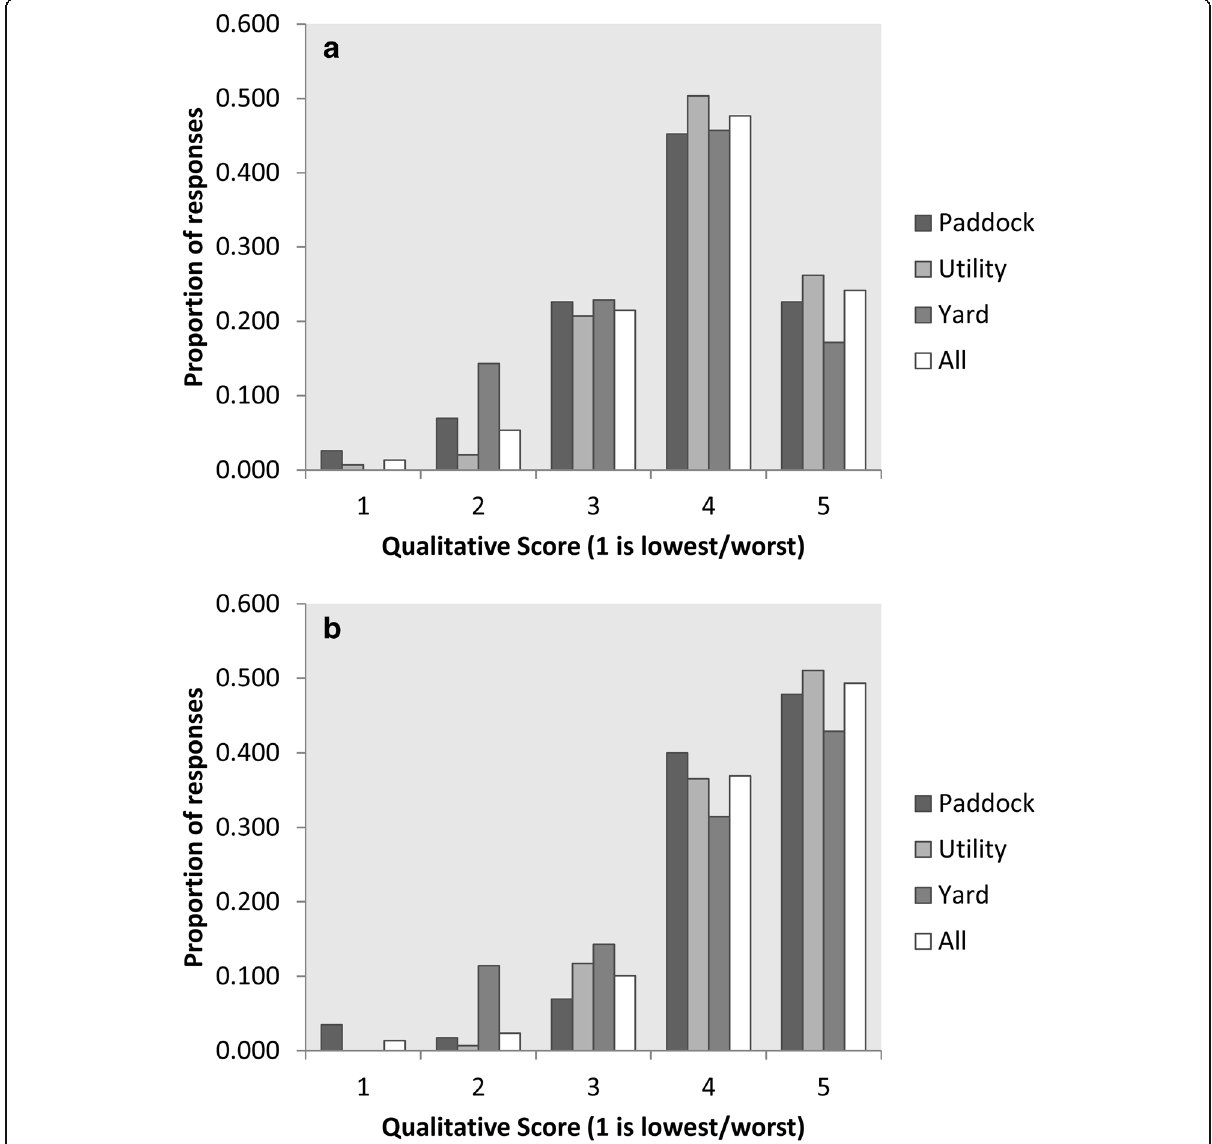
Fig. 1 Proportion of dogs at each qualitative trait score (1 = worst, 5 = best) for a overall-ability and b natural-ability by work-type in the Australian Working